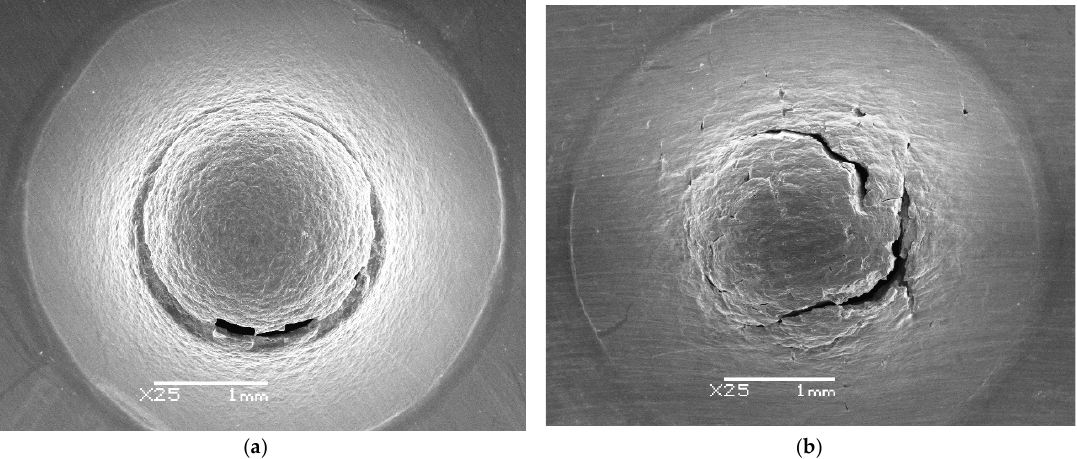
Figure 5. SEM images of macroscopic cracking morphology of the small punch test samples of the hot-rolled plate ( a ) and 3D-printed block ( b ).